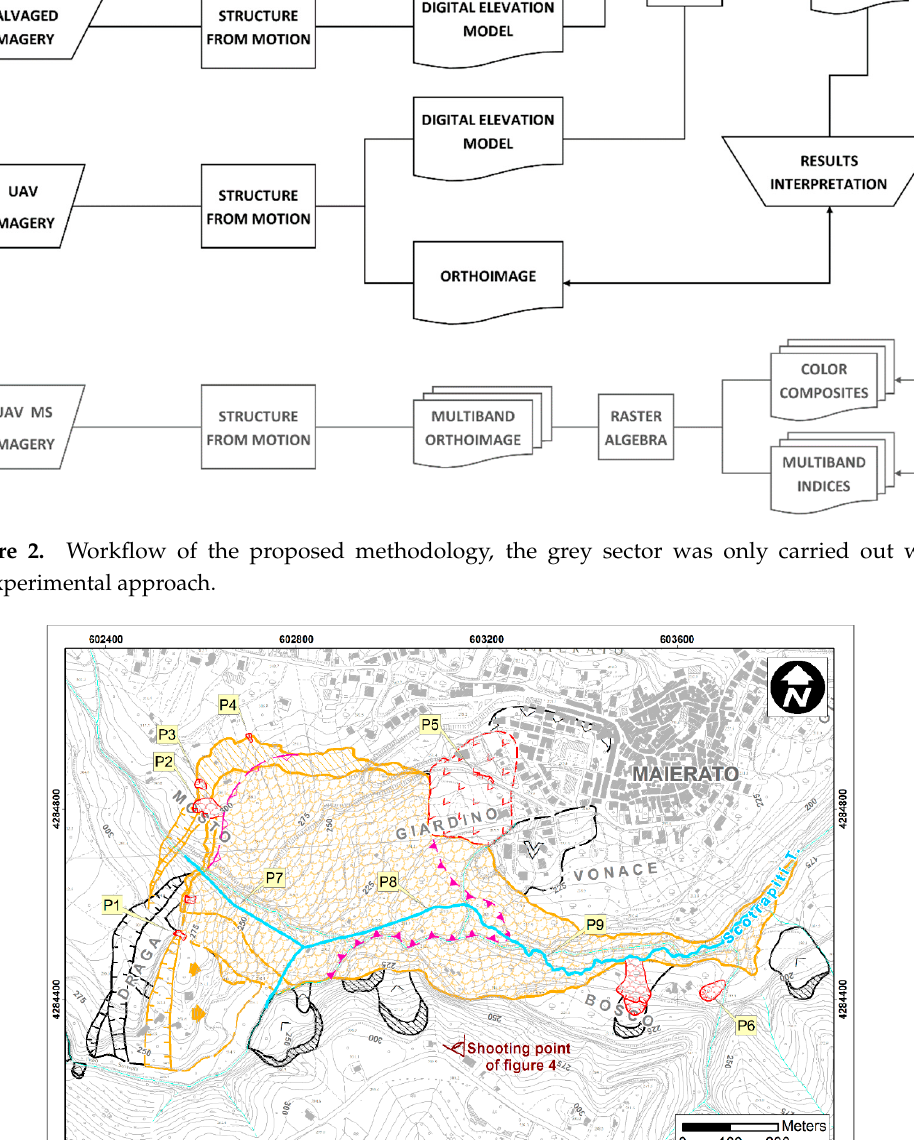
Figure 4. Photographs representing landslides (red arrows) activated in 2018 (P1–P6) and the current deepening action with local stream bank erosion along the Scotrapiti Torrent (P7–P9) (photo locations in Figure 3).